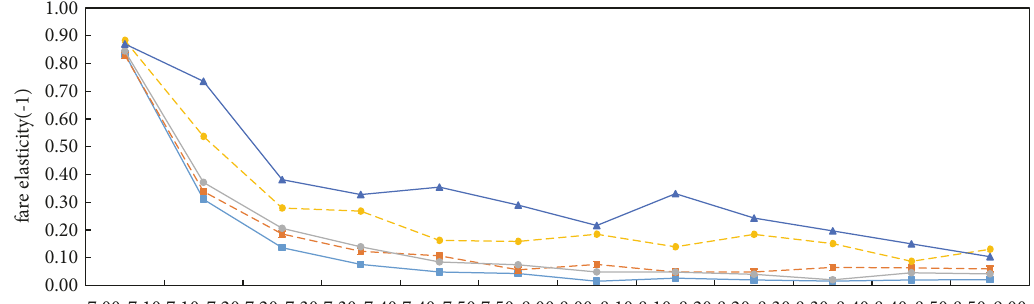
Figure 9: Distribution of retiming elasticities of different passenger groups in the short term.